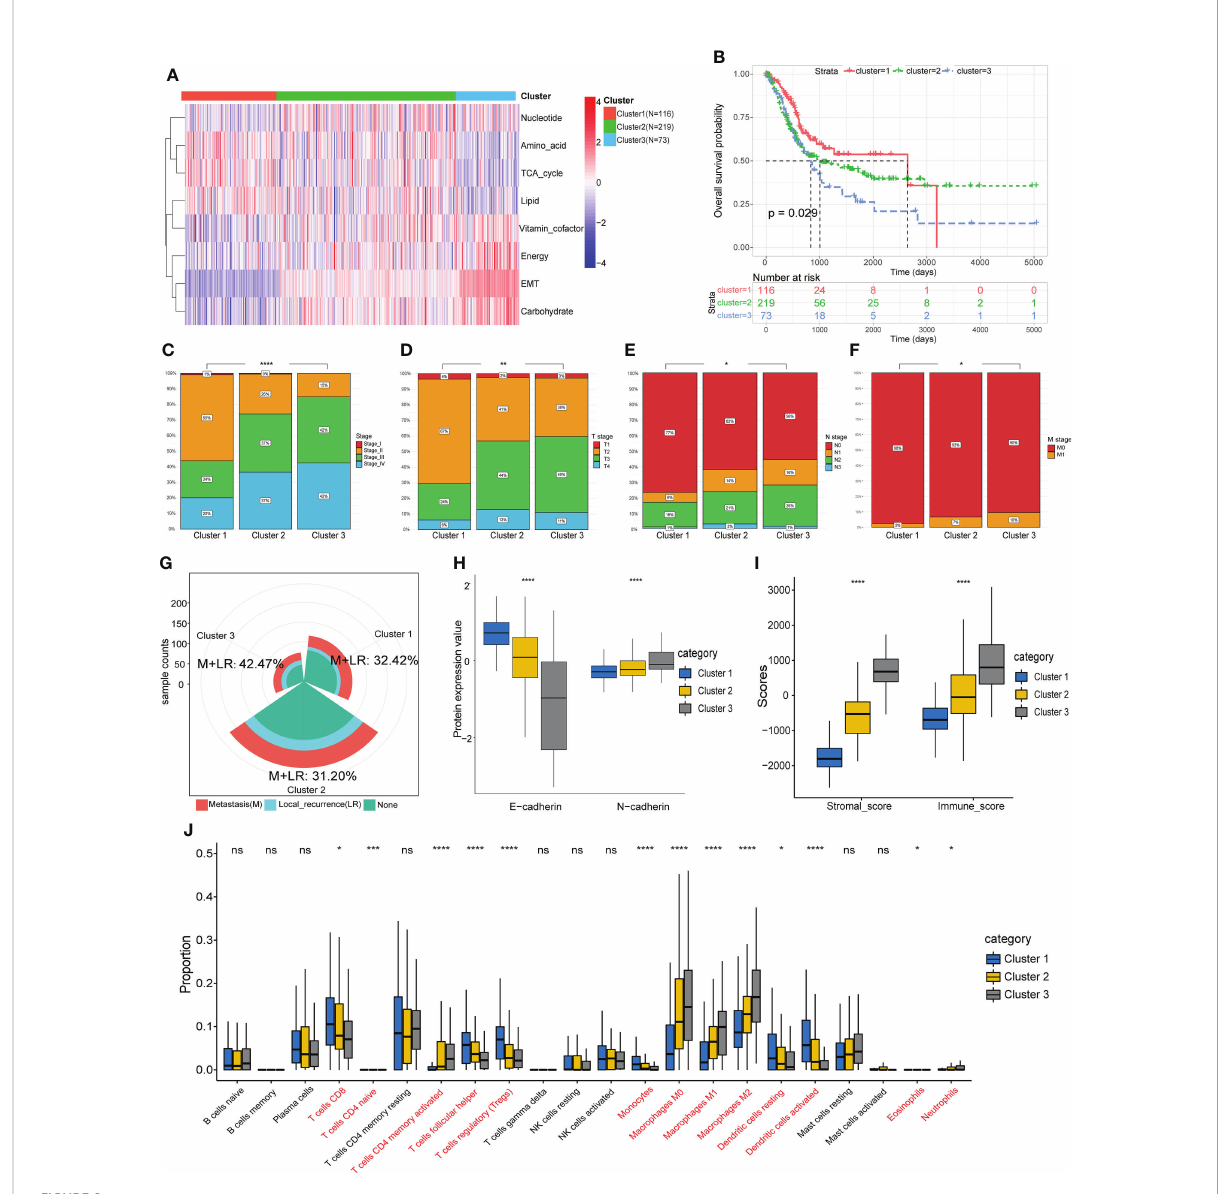
FIGURE 2 Identi fi cation of molecular subtypes based on EMT and metabolism scores. (A) The TCGA cohort was divided into three clusters based on cluster analysis of the ssGSEA scores. (B) Overall survival of the three clusters was compared by KM survival analysis. (C-F) Comparison of clinical characteristics between the three clusters. (G) Comparison of the proportion of metastasis and local recurrence after receiving chemotherapy. (H) Comparison of the expression levels of EMT marker proteins. (I) Comparison of the ESTIMATE scores. (J) Comparison of the in fi ltration of 22 leukocyte types among three clusters. *p<0.05, ** p<0.01, *** p<0.001, **** p<0.0001, ns: no signi fi